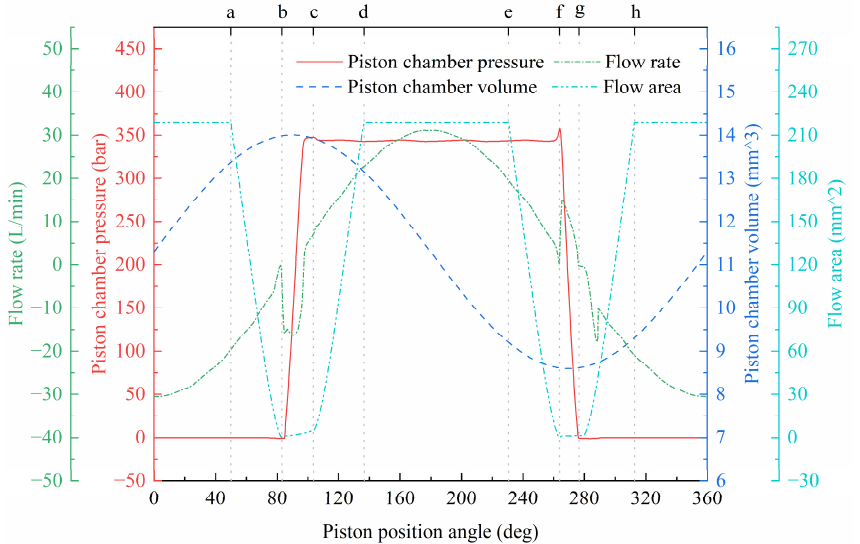
Figure 21. Dynamic characteristics of the piston chamber in one cycle. a – h are critical positions between work stages.